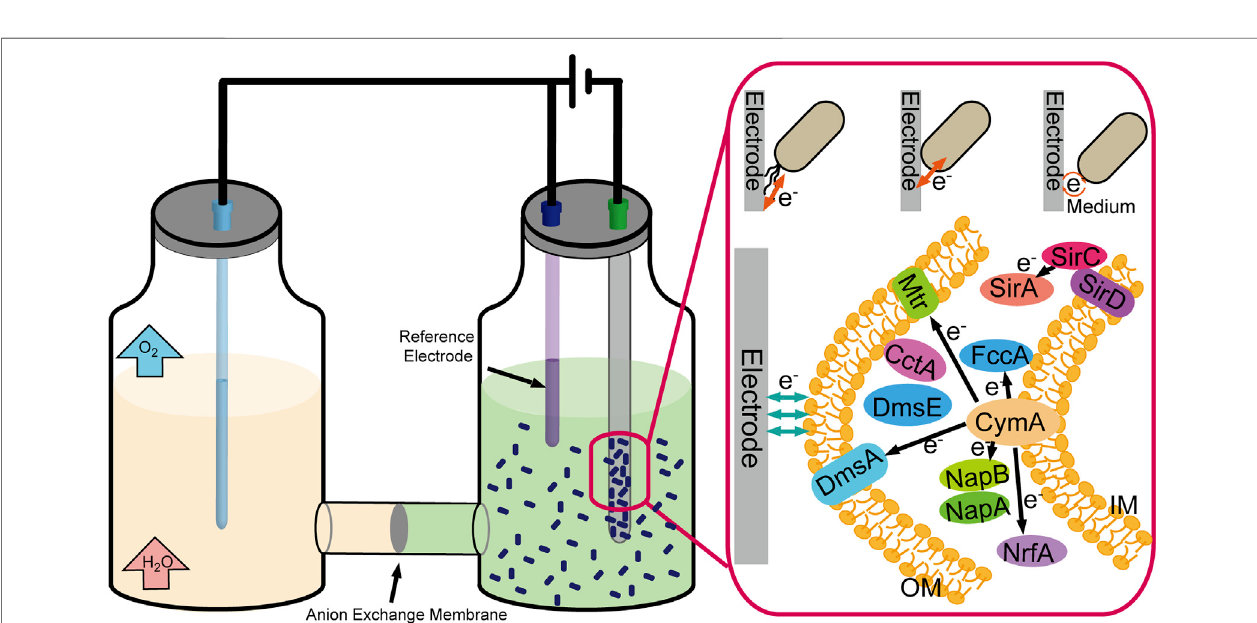
FIGURE 5 | Schematic representation of the CO 2 fi xation process by electrically driven microorganism.